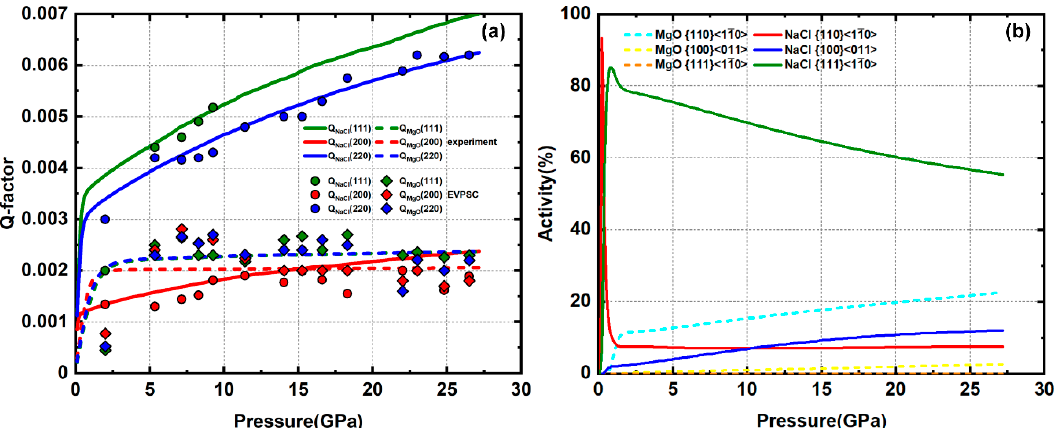
Figure 10. ( a ) Experimental and modeled Q-factors of 50% MgO + 50% NaCl. ( b ) slip system activity of MgO and NaCl.